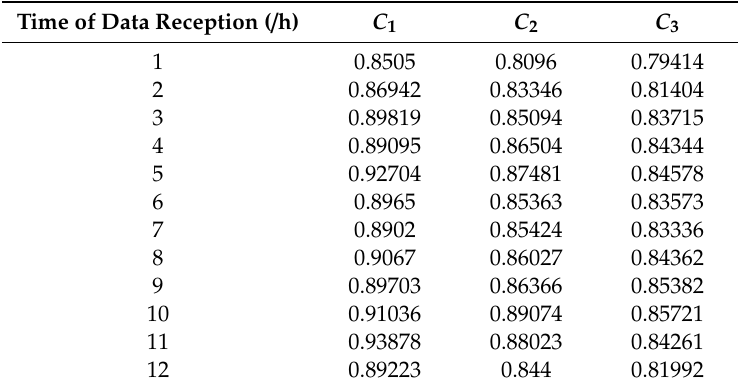
Table 1. Threshold set of the k th scan window when STWL = 3, CRF =